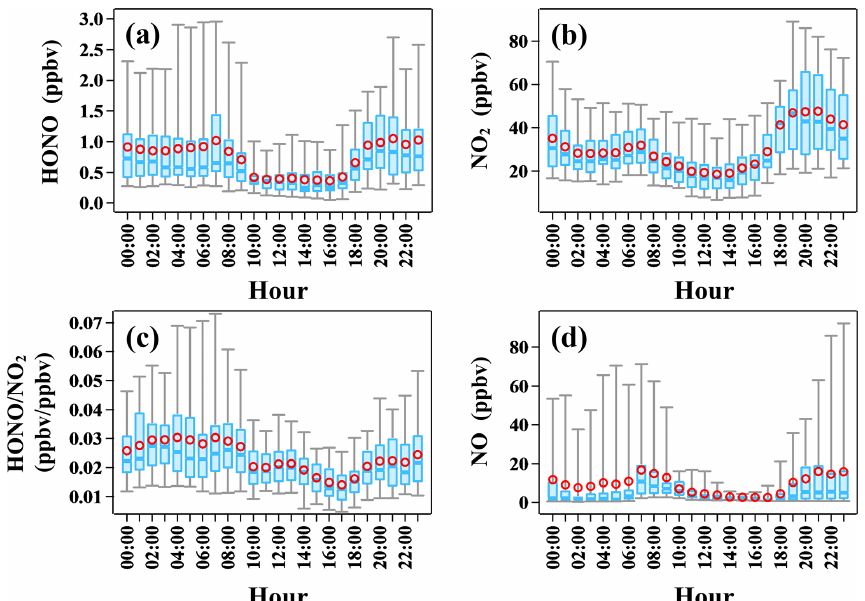
Figure 2. Diurnal profiles of (a) HONO, (b) NO 2 , (c) HONO / NO 2 , and (d) NO during the observation period. In each box, the blue line and the red circle refer to the median and mean, respectively. The upper and lower boundaries of each box represent the 75th and the 25th percentiles; the whiskers above and below each box represent the 95th and 5th percentiles. The box plots presented in this study were generated by an Igor-Pro-based computer program, Histbox (Wu et al., 2018).